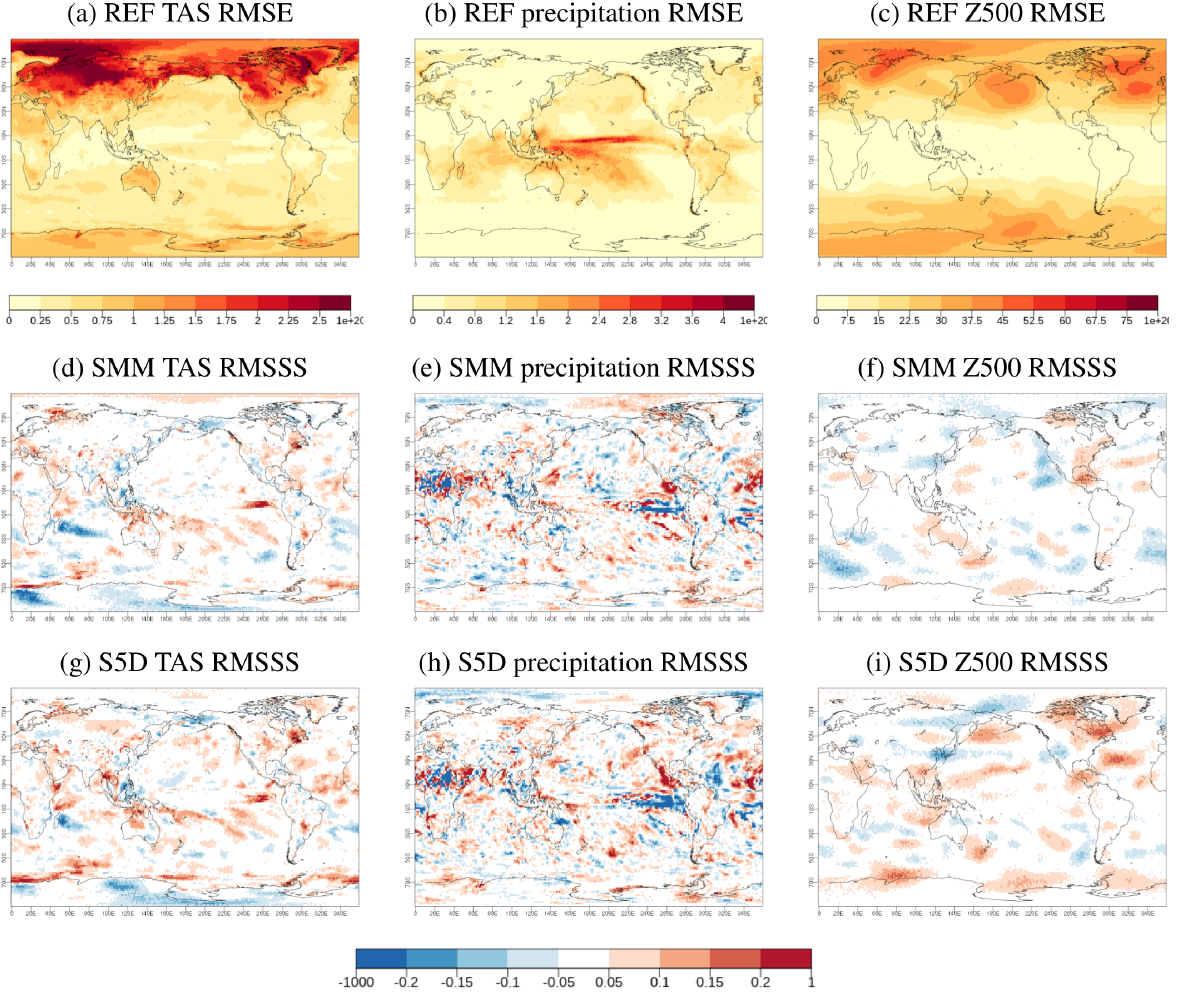
Figure 8. DJF root mean square error (RMSE) for REF (top row) computed against ERA-Interim (GPCP in the case of precipitation) over the re-forecast period for near-surface air temperature, precipitation, and Z500 (from left to right). Middle and bottom rows: SMM and S5D root mean square skill score (RMSSS) using REF as a reference forecast. Areas in blue indicate where the RMSE is higher than in REF, whereas areas in shades of red show where the RMSE is